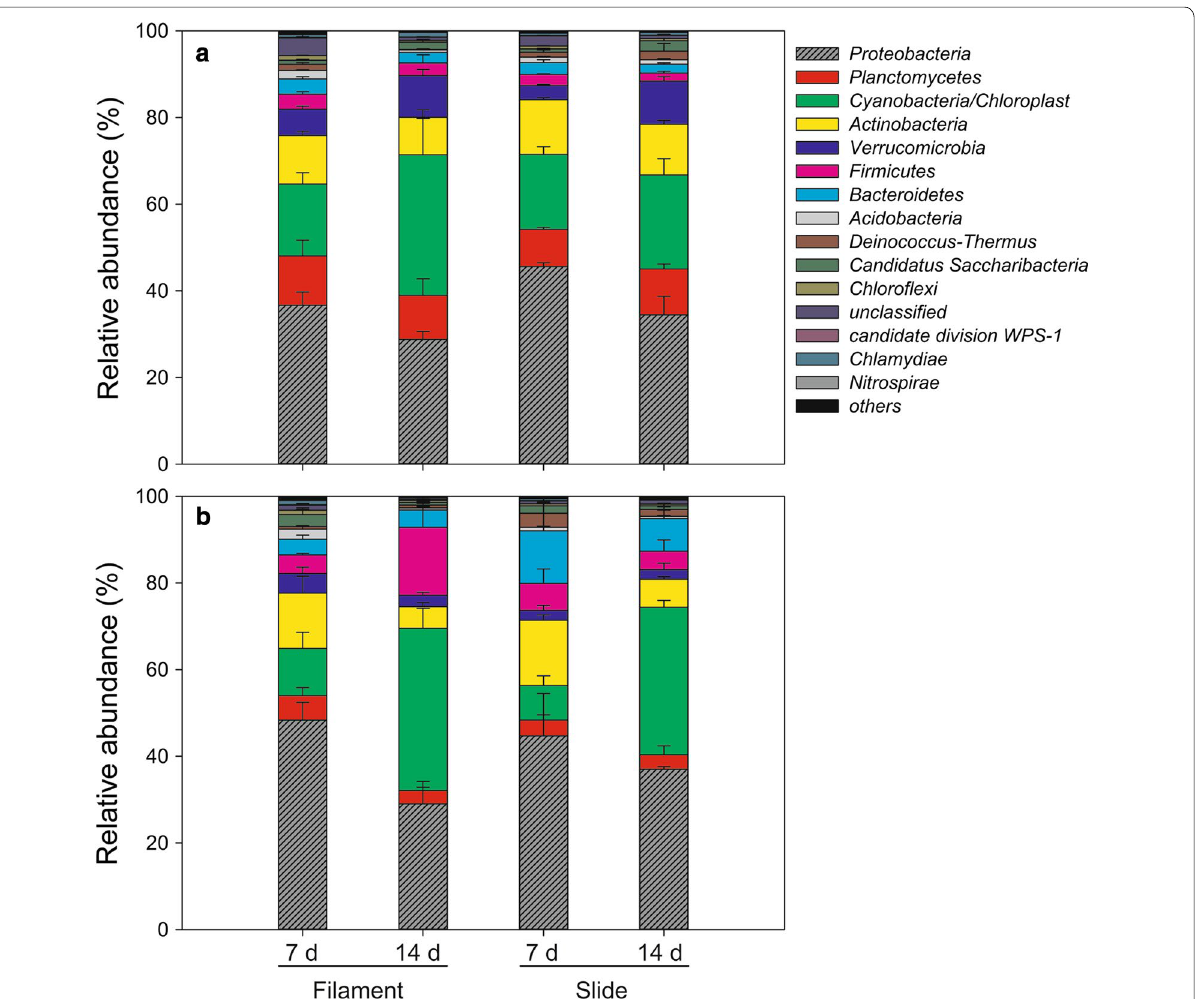
Fig. 3 Effects of sampling time, site and substrate type on the dominant phyla of surface-associated bacteria. The sum relative abundance of domi- nant phyla exceeded 99%. a Site A lentic; b Site B = =